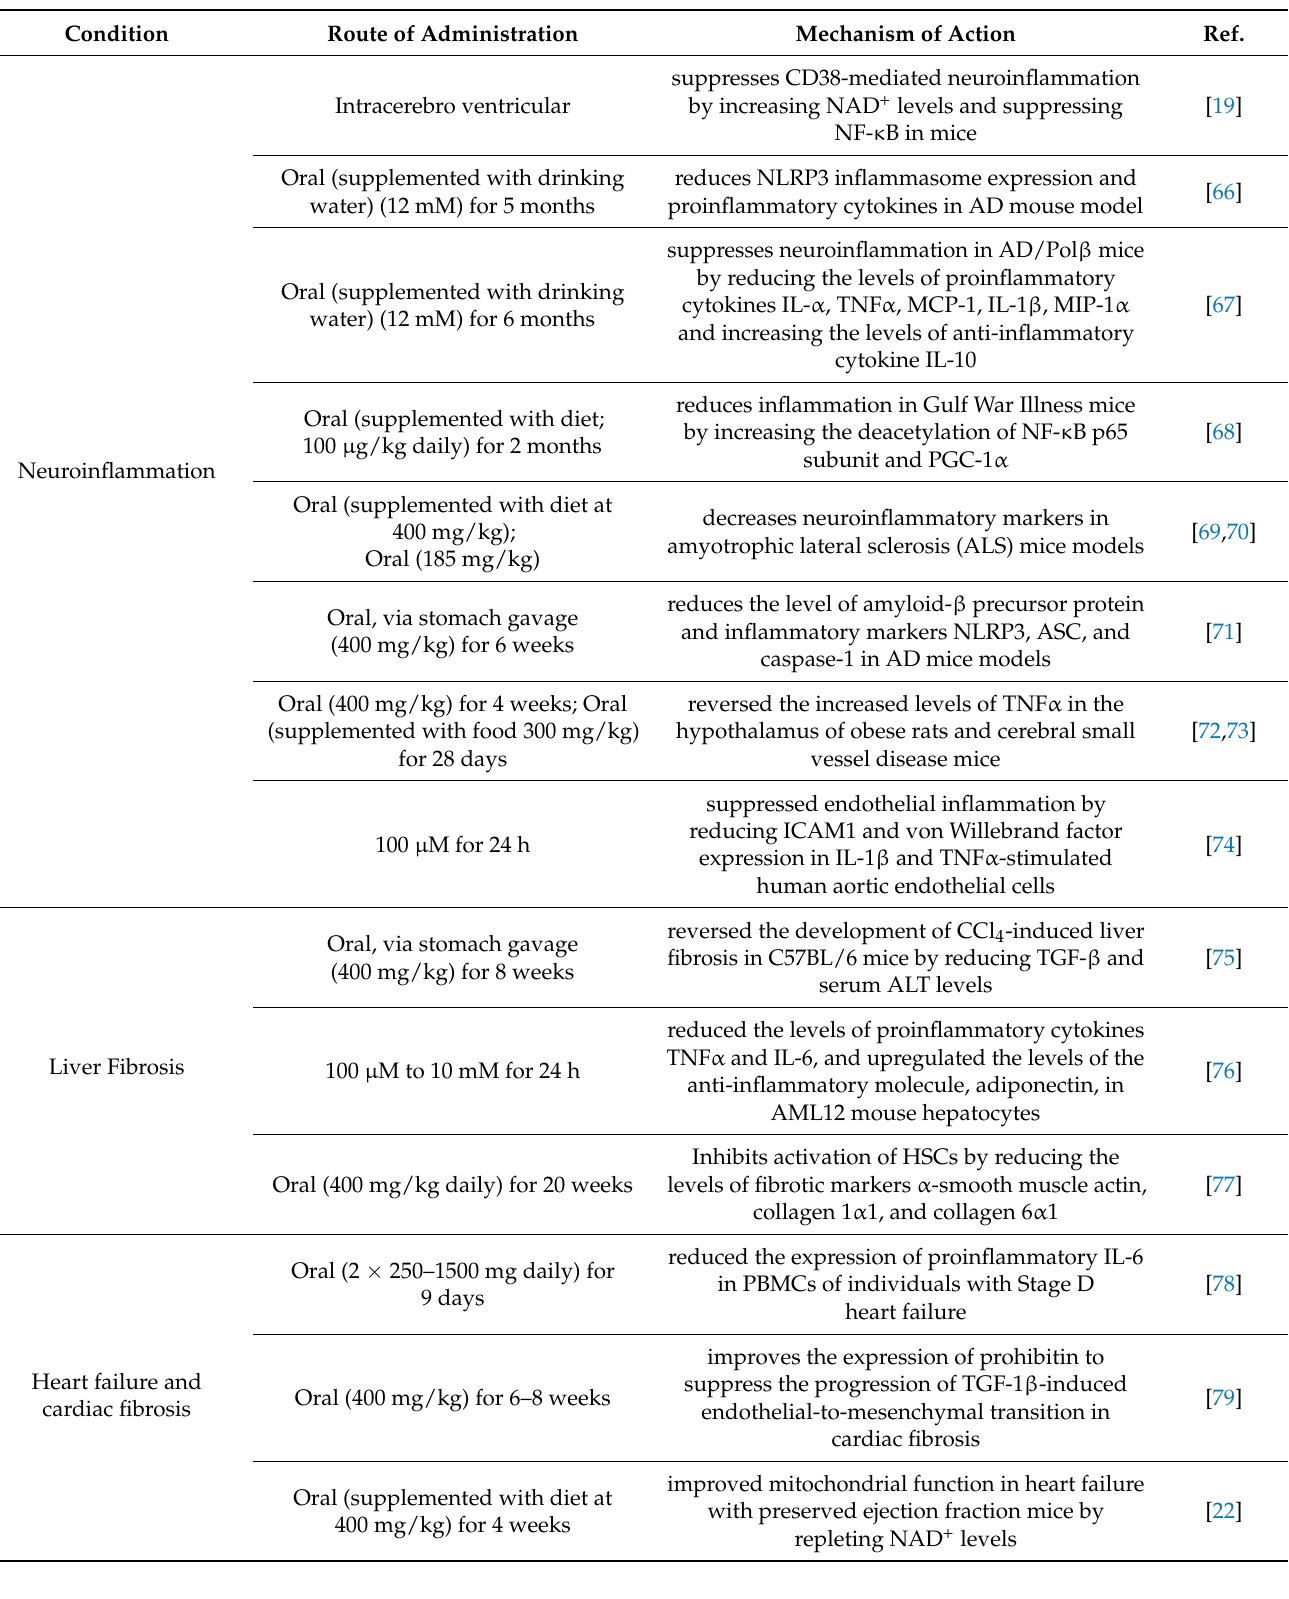
Table 1. Role of NR in health and different disease